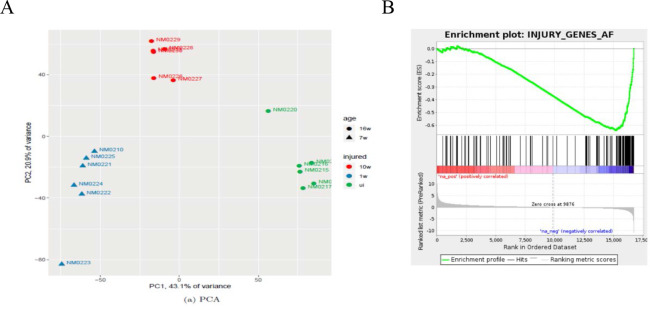
Bioinformatics analysis of nerves after chronic injury.(A) PCA showing the key sources of variance in our chronic injury analysis are not only injury dependent but also time post-injury dependent, with samples clustering based on length of denervation regardless of genotype. (B) GSEA of WT chronically denervated nerves showed that c-Jun genes were some of the most downregulated genes during chronic denervation NES = −2.5, q-value = 0.0.